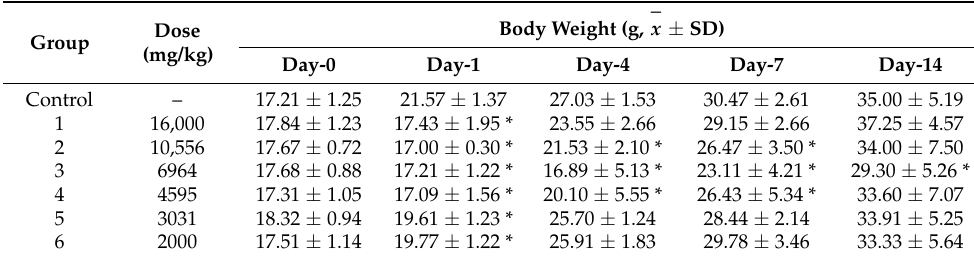
Table 3. Changes in the body weight (g, x ± SD) of the tested KM mice caused by EFX-Ca at